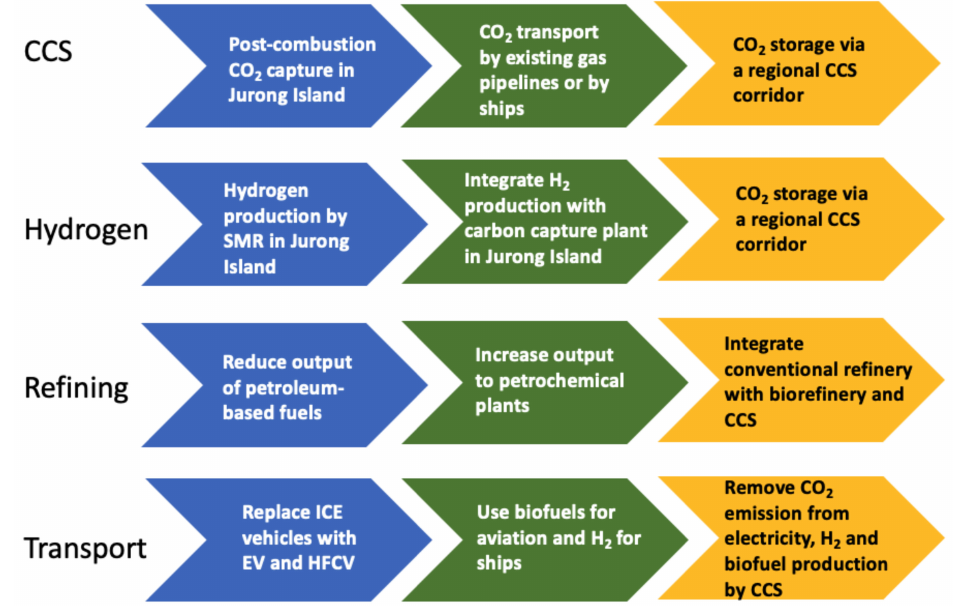
Figure 6. Key elements of the decarbonization roadmap.